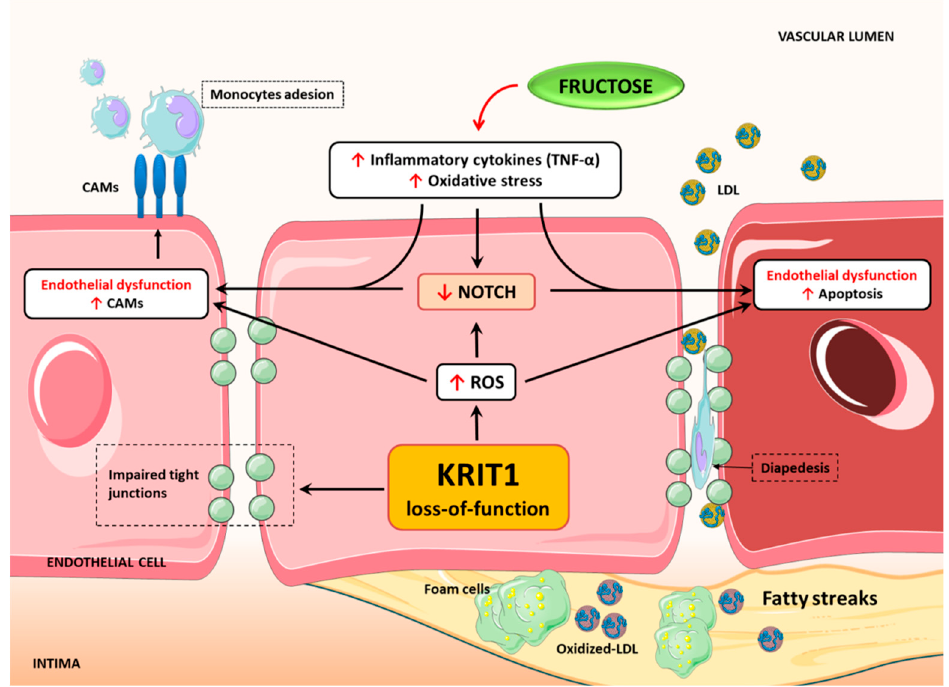
Figure 5. KRIT1 deficiency induces endothelial dysfunctions (ED) through redox-dependent mechanisms. Schematic model representing the effects of KRIT1 deficiency in the arterial endothelium: KRIT1 loss-of-function causes a redox-sensitive downregulation of Notch signaling and upregulation of major hallmarks of ED, including increased expression of endothelial CAMs and enhanced susceptibility to apoptosis. In turn, these events facilitate oxidative stress and inflammatory responses that enable subendothelial fat accumulation in atheroprone aortic regions of KRIT1 haploinsufficient